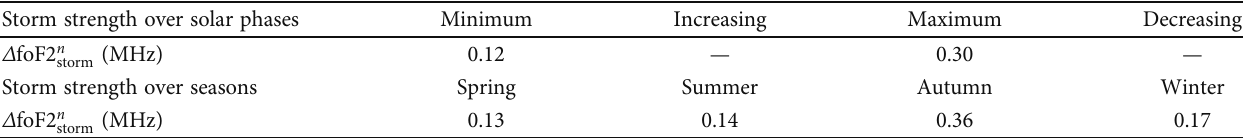
20020406080 − LT (d) Figure 4: Seasons ’ in fl uence on foF2 diurnal variations during recurrent events (REs). Table 1: Recurrent events ’ positive storms strength on foF2 variation by solar phase and by season. Storm strength over solar phases Minimum Increasing Maximum Decreasing Δ foF2 p storm (MHz) 0.64 0.88 0.61 1.38 Storm strength over seasons Spring Summer Autumn Winter Δ foF2 p storm (MHz) 1.18 0.33 0.76 0.93 Table 2: Recurrent events ’ negative storms strength on foF2 variation by solar phase and by season. Storm strength over solar phases Minimum Increasing Maximum Decreasing — 0.30 — Δ foF2 n storm (MHz) 0.12 Storm strength over seasons Spring Summer Autumn Winter Δ foF2 n storm (MHz) 0.13 0.14 0.36